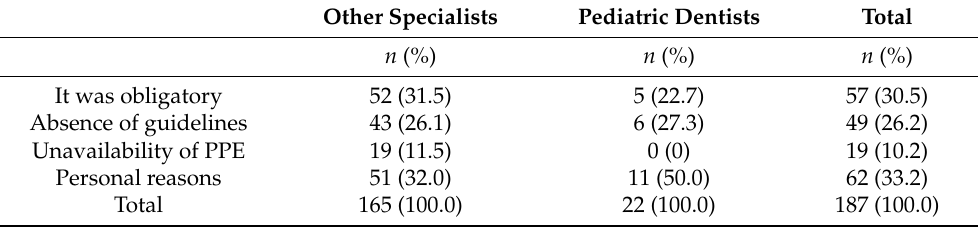
Table 4. Reasons for stopping the clinical practice during first wave of COVID-19 pandemic. Other Specialists Pediatric Dentists